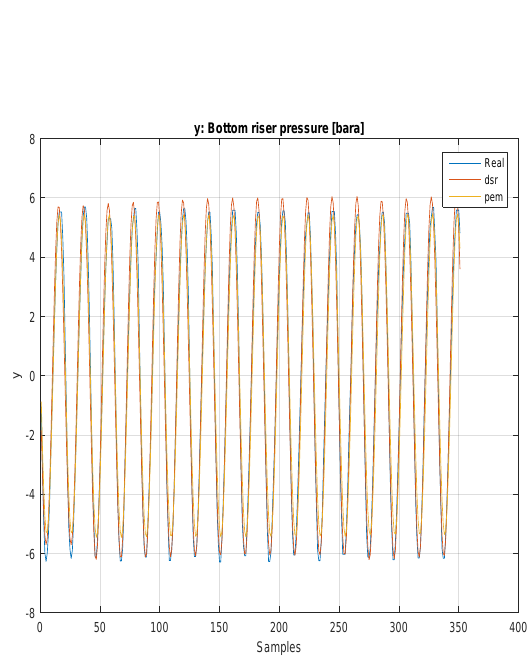
Figure 16: Illustration of the identified models simu- lated over the unused part of the validation set. We have V = 0 . 3932 V PEM = DSR 8 8 0 . 5039. See Fig. 13. for details.